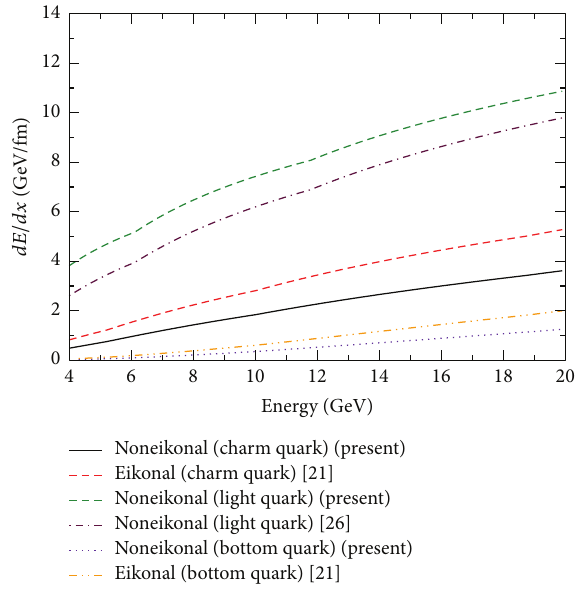
Figure 4: Energy loss of quarks in a thermal bath of 300